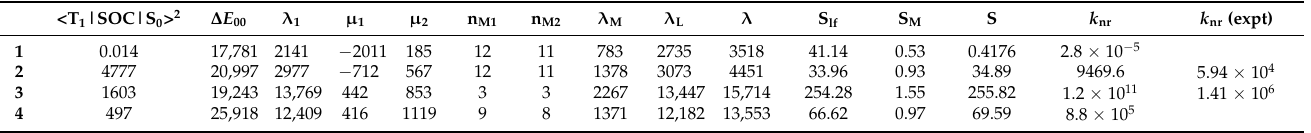
Table 6. Calculated spin–orbit coupling matrix, emission energy ∆ E 00 , reorganization energy λ , Huang–Rhys factor ( S ) and the parameters related to k nr . (Energy unit in cm − 1 , rate unit in s − 1